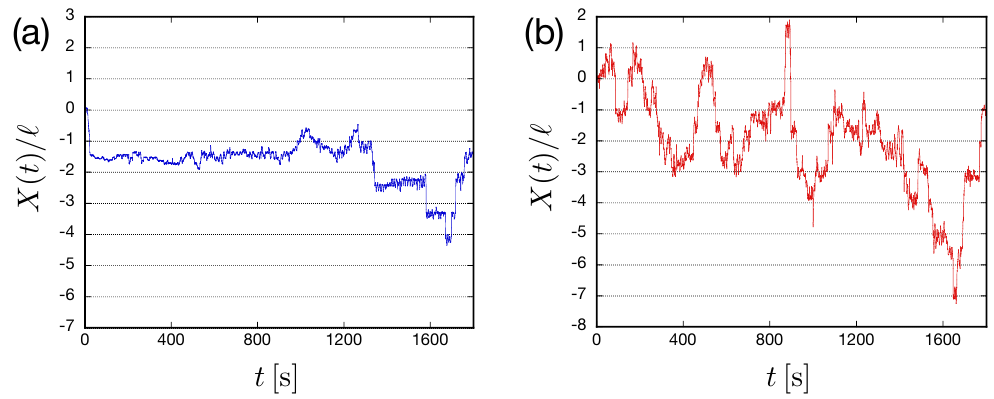
Figure 2. Particle position X ( t ) for ( a ) ε = 0.5 and ( b ) ε = 1.0. The vertical axes are normalized using the averaged width (cid:96) of a convective roll, specifically, (cid:96) = 32.4 m for ε = 0.5, and 31.5 µ m for ε =